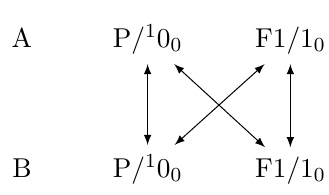
Figure 2 . The T-duality orbit of the F1 = 1 0